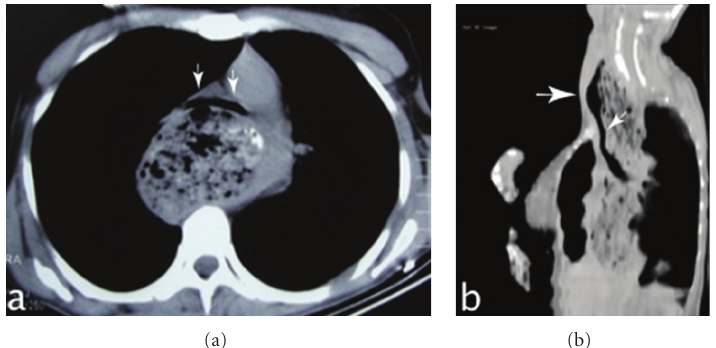
Figure 2: (a) Axial cross-section shows stenosis resulting from the pressure of the oesophagus on the trachea at the carina level (arrows). (b) Sagittal cross-section shows that the diameter of the proximal trachea is normal (large arrow), and stenosis of the lumen is present due to the pressure on the distal trachea (small